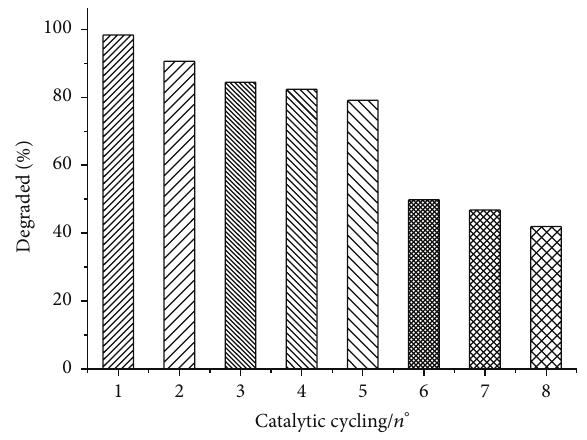
Figure 7: Recycling and reuse of 0.1 gL −1 of TiO 2 on the photocat- alytic degradation of 30 mgL −1 of IC for an accumulated energy, 𝑄 of 15 kJL −1